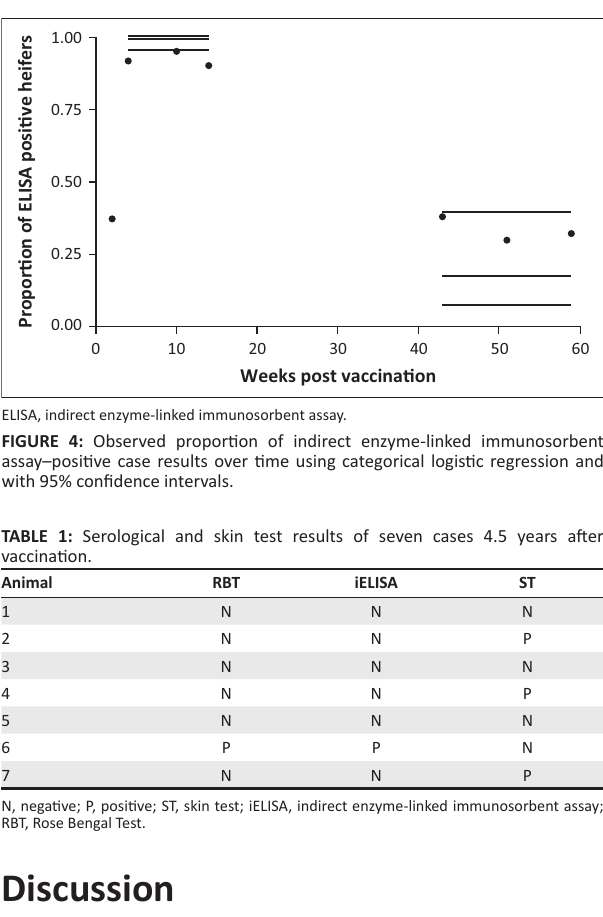
FIGURE 3: Observed proportion of Rose Bengal Test–positive case results over time using quadratic logistic regression and with 95 % confidence